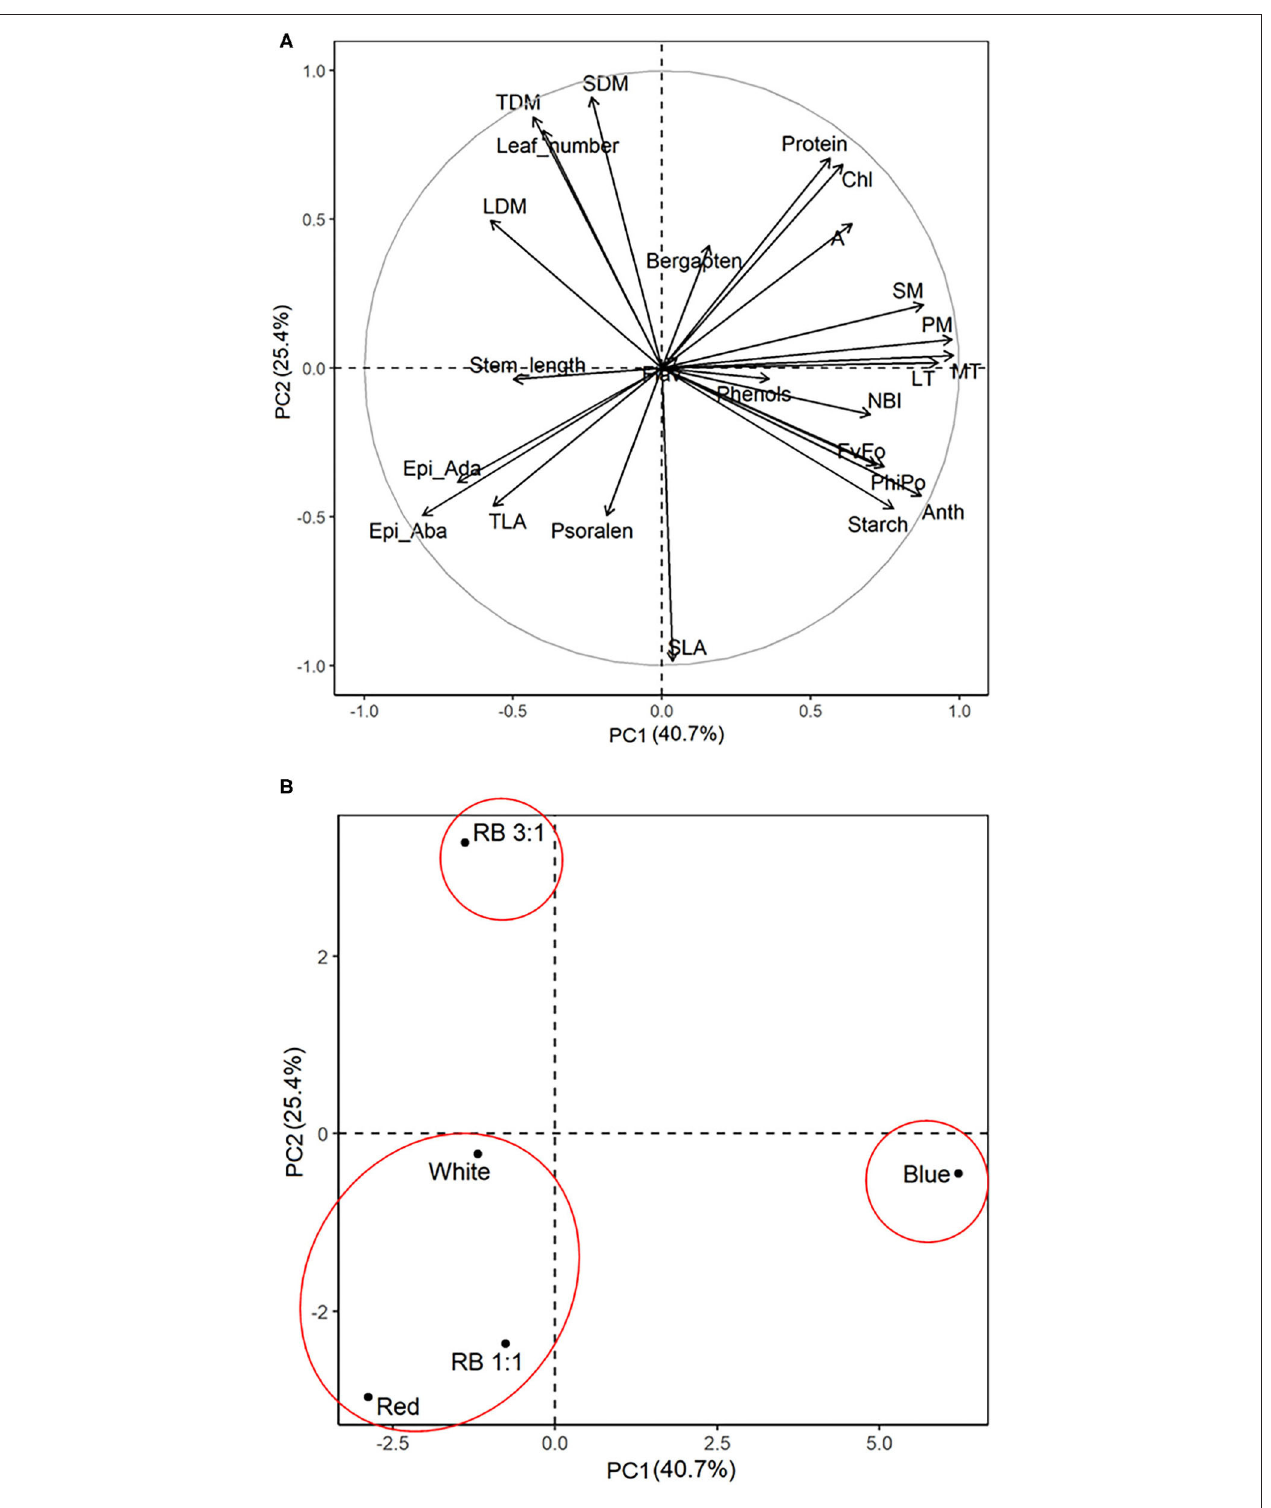
FIGURE 9 | Principal component analysis of biometric, physiological, anatomical, and metabolic characteristics associated with different light qualities. The correlation coefficients for all the analysis (A) and the segregation of the experimental groups (B) were plotted in the first two component spaces. Leaves, number of leaves; length, stem length; LDM, leaf dry matter; SDM, stem dry matter; TLA, total leaf area; TDM, total dry matter; SLA, specific leaf area; Chl, chlorophyll; Flav, flavonoids; Anth, anthocyanin; NBI, nitrogen balance index; FvFo, effective quantum yield of photochemical energy conversion; φ Po, maximum quantum yield of primary photochemistry; A, photosynthetic rate; EpiAda, adaxial epidermis; EpiAba, abaxial epidermis.